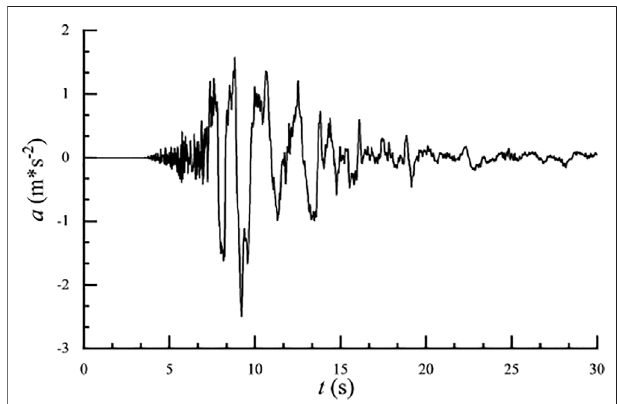
FIGURE 2 | Acceleration time series of KOBE wave.